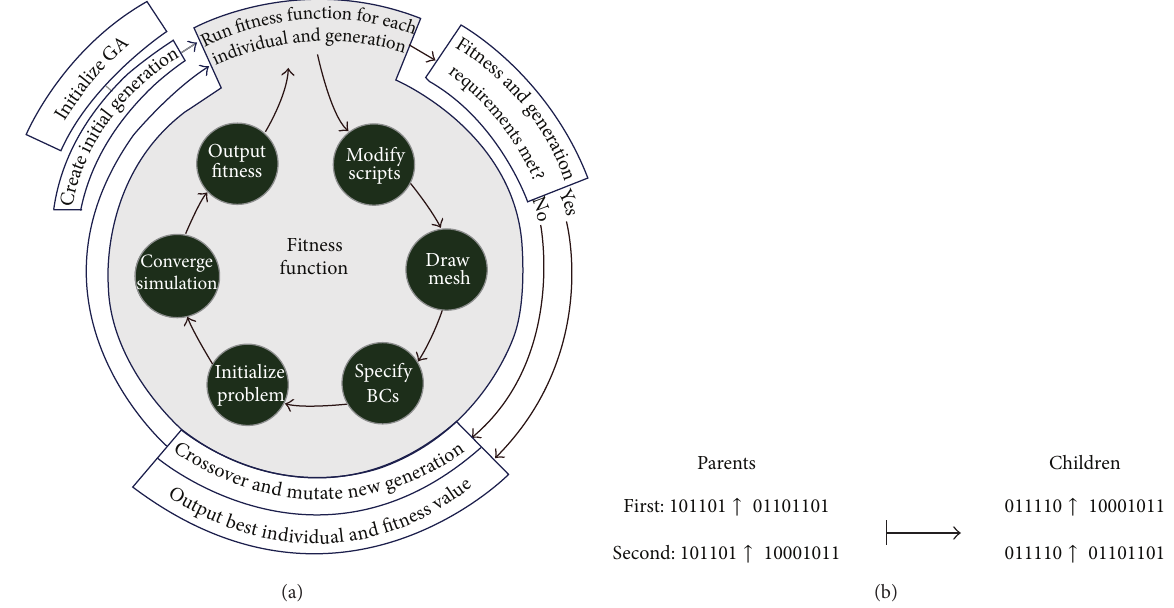
Figure 2: (a) The general scheme of GA mechanism. (b) Single point method at random point